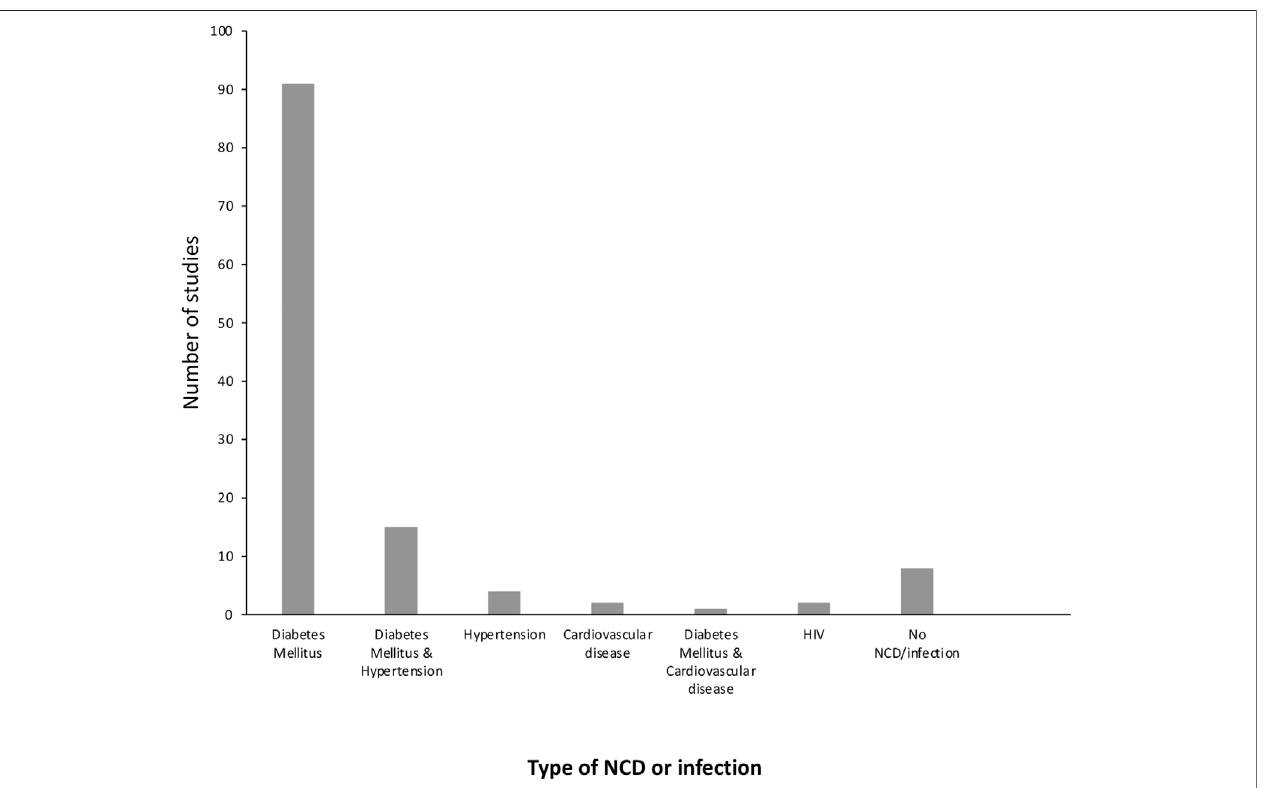
FIGURE 2 | The number of papers describing each of the comorbidities associated with